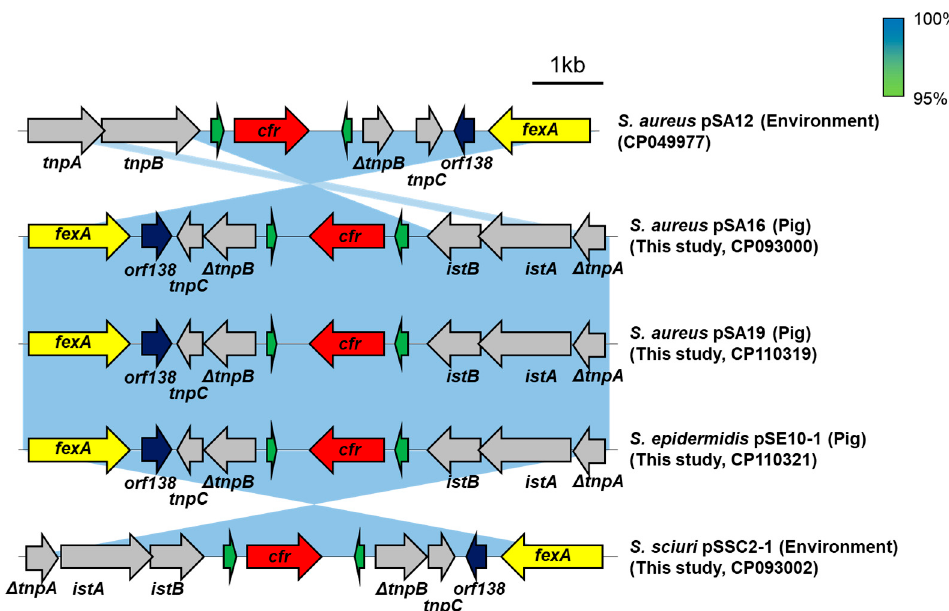
Figure 2. The schematic presentation of cfr Q148K harboring regions in staphylococci strains. The cfr Q148K genes are located on 38-kb plasmids (pSA16, pSA19, pSE10-1, and pSSC2-1) of staphylococci strains. Different colored arrows indicate that different genes with the direction of transcription; red arrows represent cfr genes; yellow arrows represent fexA genes; green arrows represent IS elements; blue arrows represent orf138 genes; gray arrows represent transposon elements. Shaded regions indicate nucleotide sequence identities ranging from 95% to 100%.